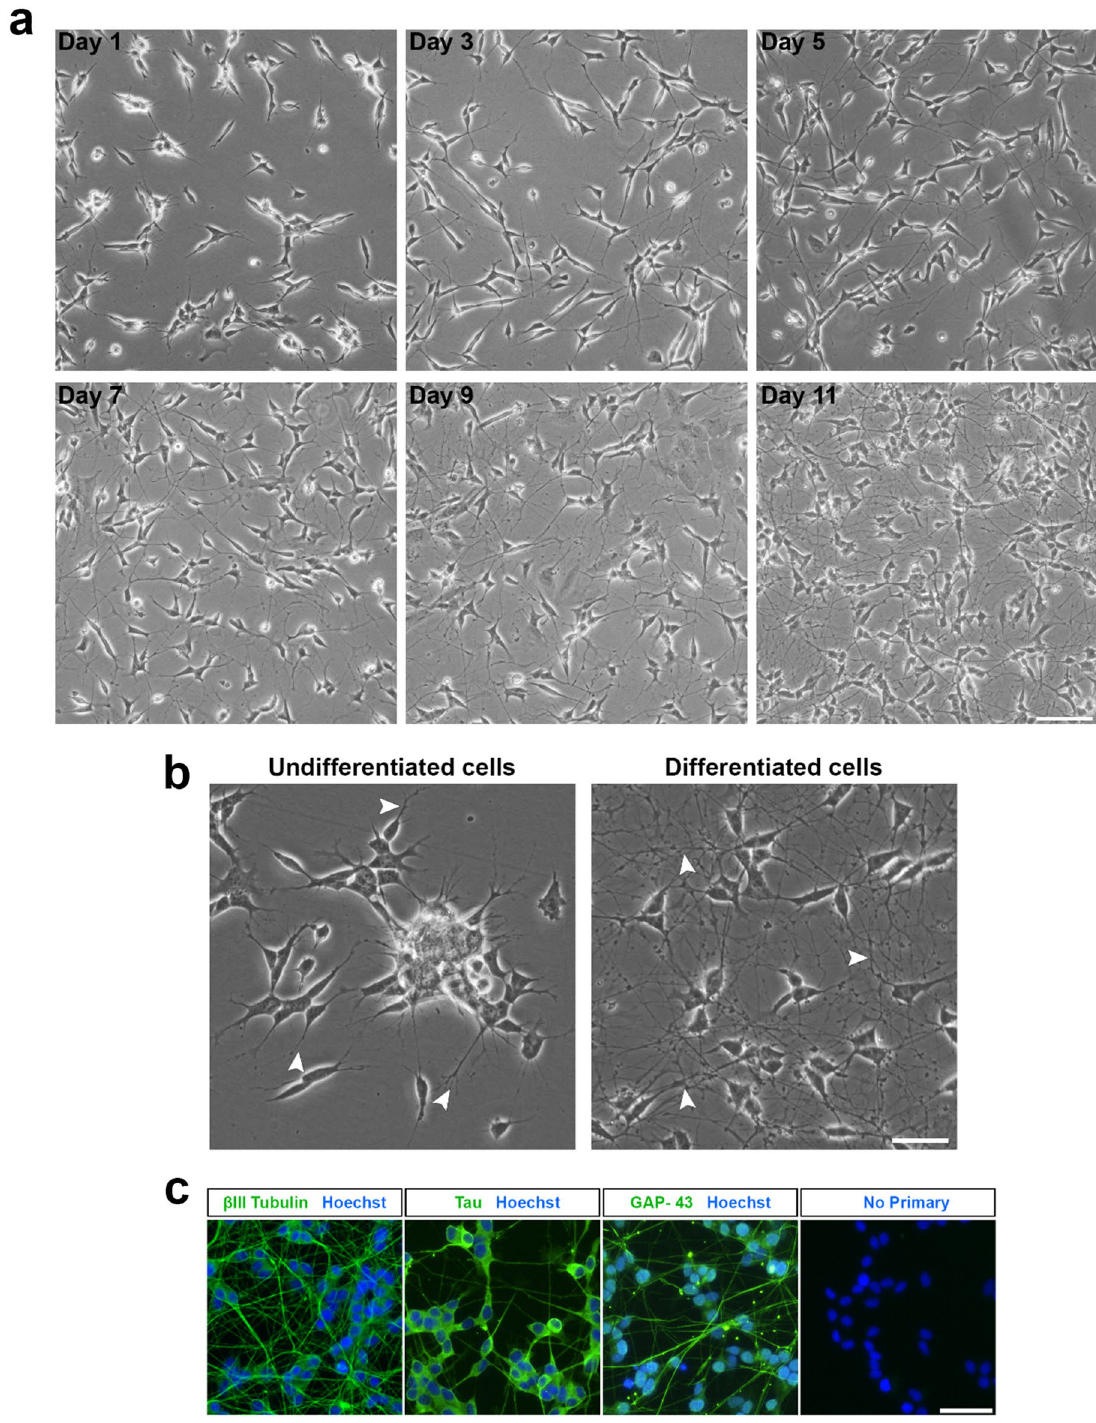
Figure 1. Differentiation of the SH-SY5Y cell line into a neuronal phenotype. ( a ) Phase contrast images of SH-SY5Y cells at various stages of the differentiation process. Cells were treated with RA (10 µM) for five days, followed by BDNF (50 ng/mL) for an additional five days to achieve terminal differentiation by Day 11. Images were acquired using an EVOS FL microscope at ×10 magnification and 43% brightness (scale bar = 50 μm). ( b ) Undifferentiated SH-SY5Y cells possess few short projections and cluster together, while differentiated cells are observed to have many extensive projections. Images were acquired at ×20 magnification and 60% brightness using an EVOS FL microscope (scale bar = 25 μm). βIII-tubulin images were acquired using the GFP filter (excitation 482/25 nm; emission 524/24 nm; exposure 110 ms), while Hoechst nuclei images were acquired using the DAPI filter (excitation 357/44 nm; emission 447/60 nm; exposure 19 ms). White arrowheads point towards neurite extensions. ( c ) Expression of mature neuronal markers by differentiated cells. Fluorescence images were acquired at ×20 magnification using an EVOS FL Auto microscope (scale bar = 25